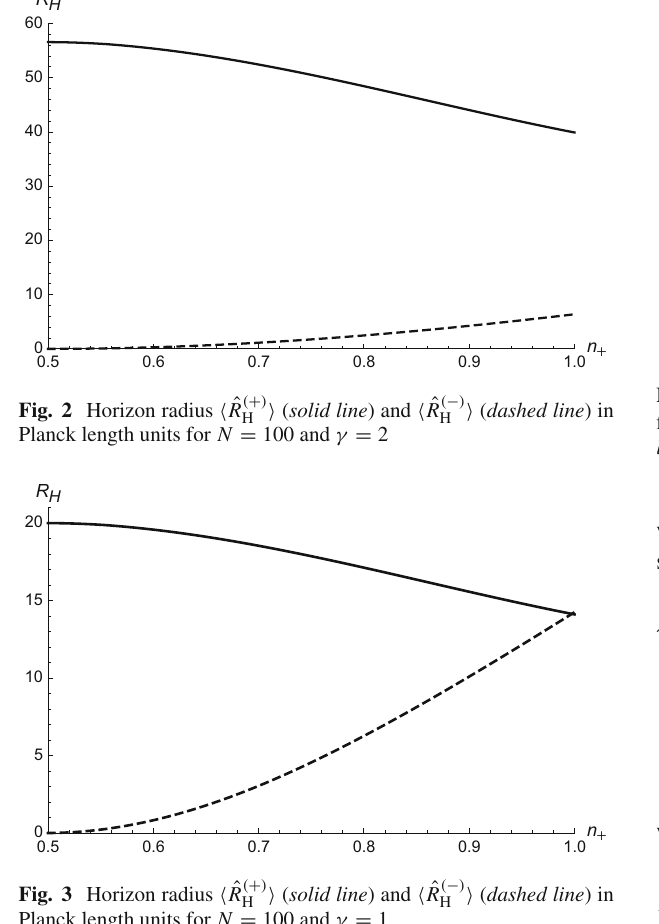
Fig. 3 Horizon radius (cid:7) ˆ R ( + ) Planck length units for N = 100 and γ = 1